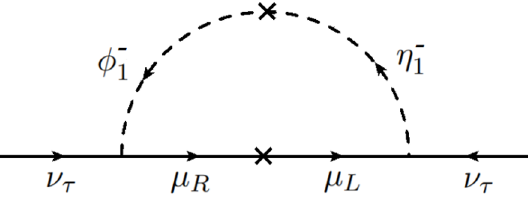
Figure 4 . Feynman diagrams generating (cid:23) (cid:28) mass in the SU(2) H